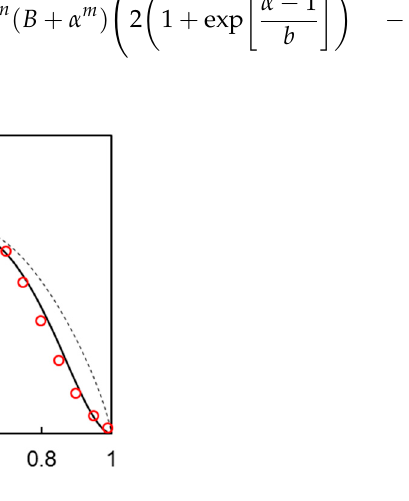
Figure 10. Comparison of the experimental polymerization rate curves (triangles) with those estimated with (solid line) and without (dashed line) accounting for diffusion control.